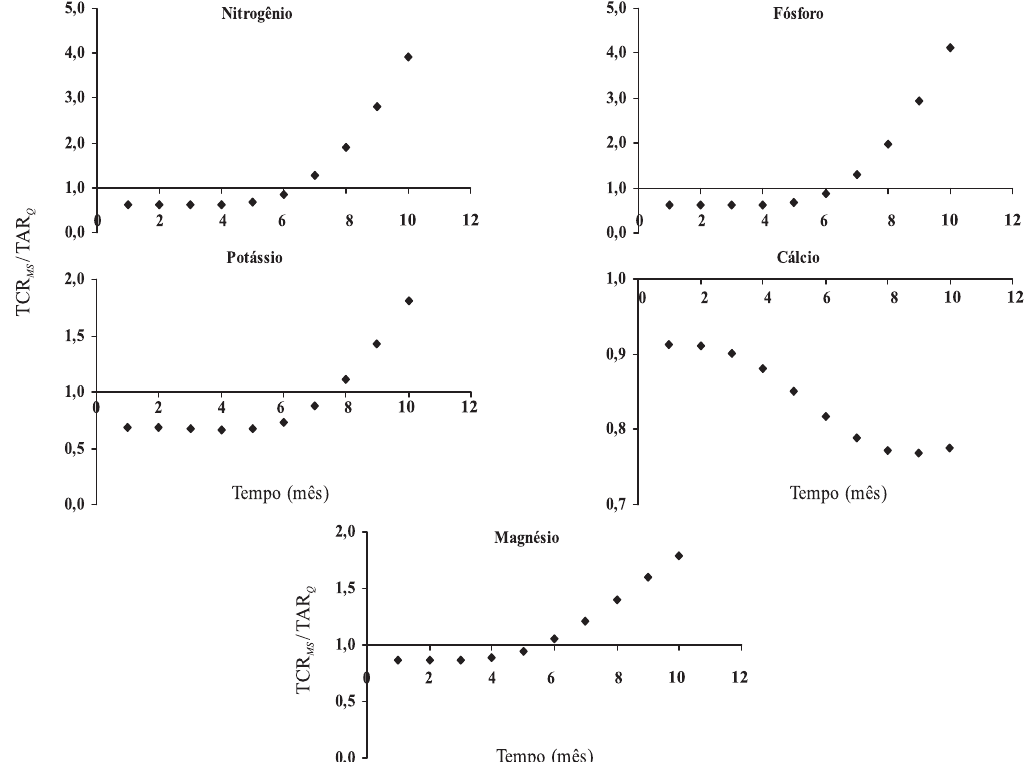
Figura 1. Valores da relação tcr ms /tar Q em função da idade da bananeira para n, p, K, ca e